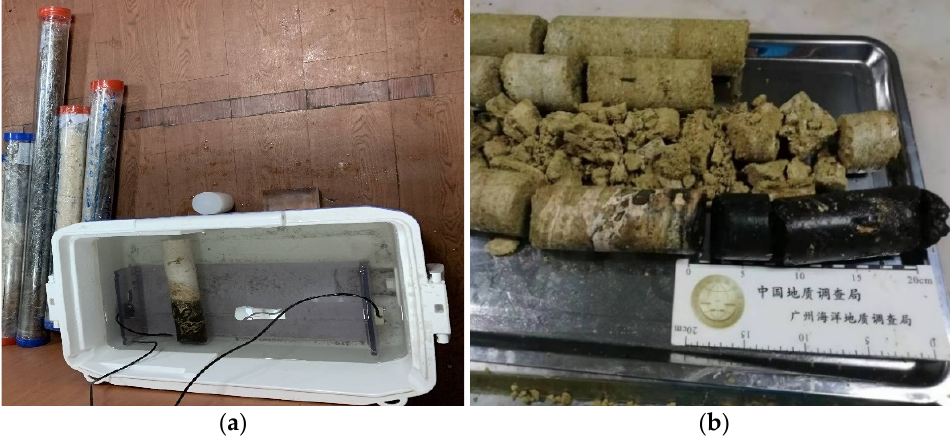
Figure 10. Samples of the survey area. ( a ) Several samples of FC and NonFC. ( b ) Other samples of FC and NonFC and the card indicates that they were obtained by Guangzhou Marine Geological Survey.